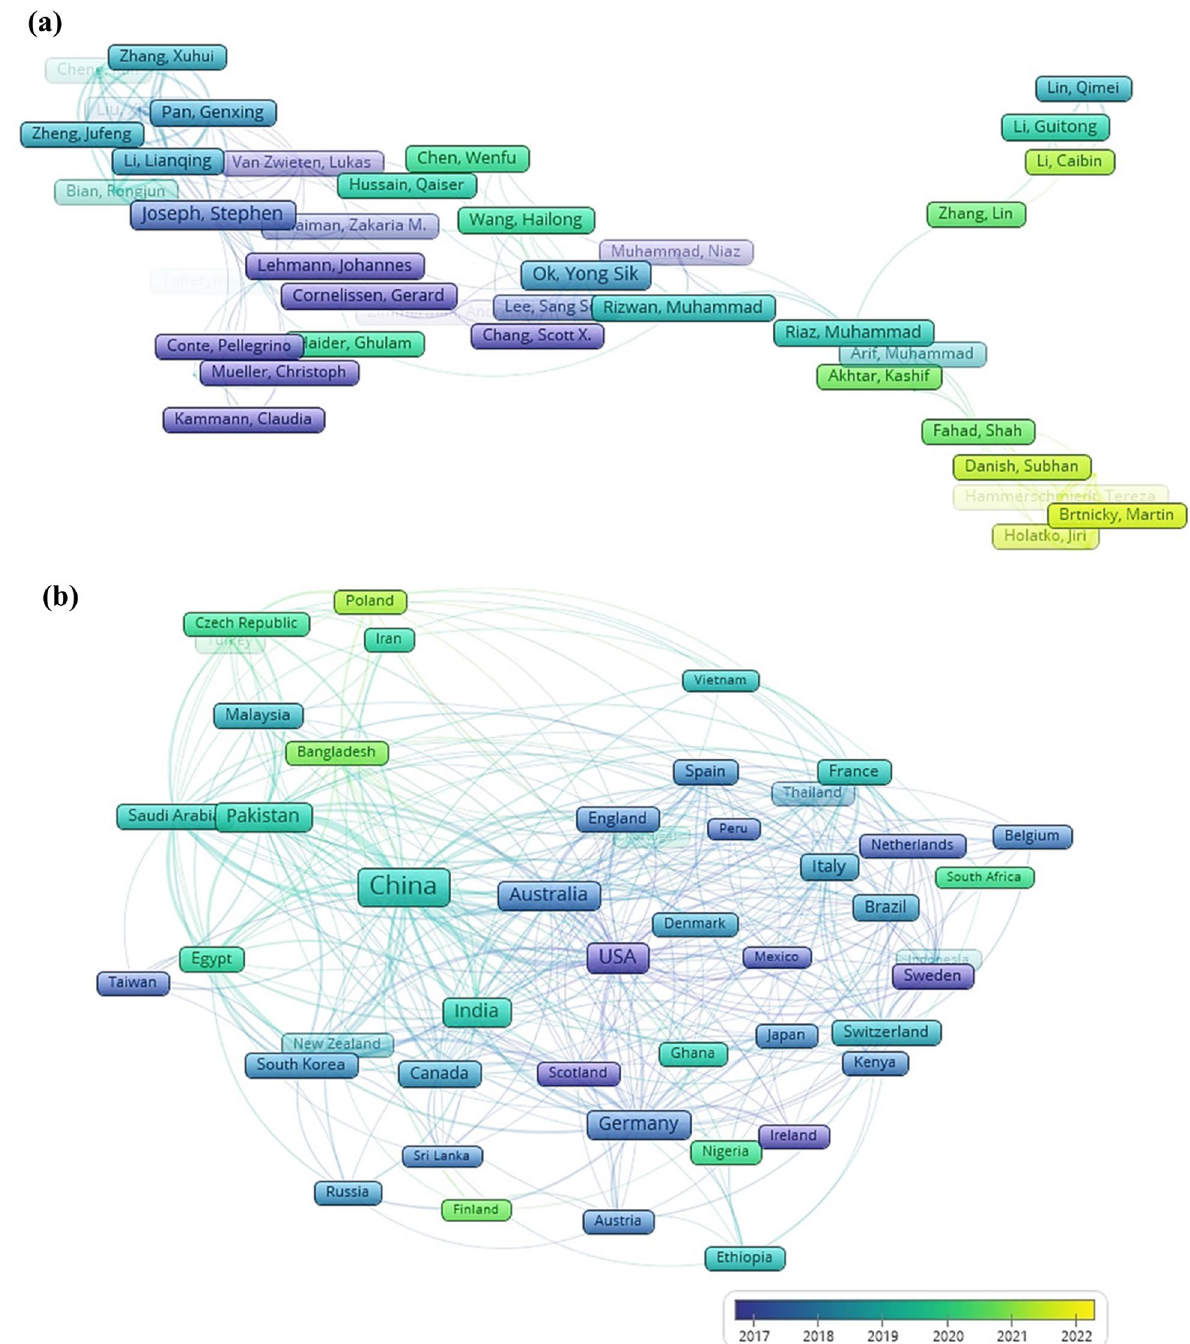
Fig. 4 Bibliometric network for improvement of soil fertility between a authors and b countries at minimum 5 document